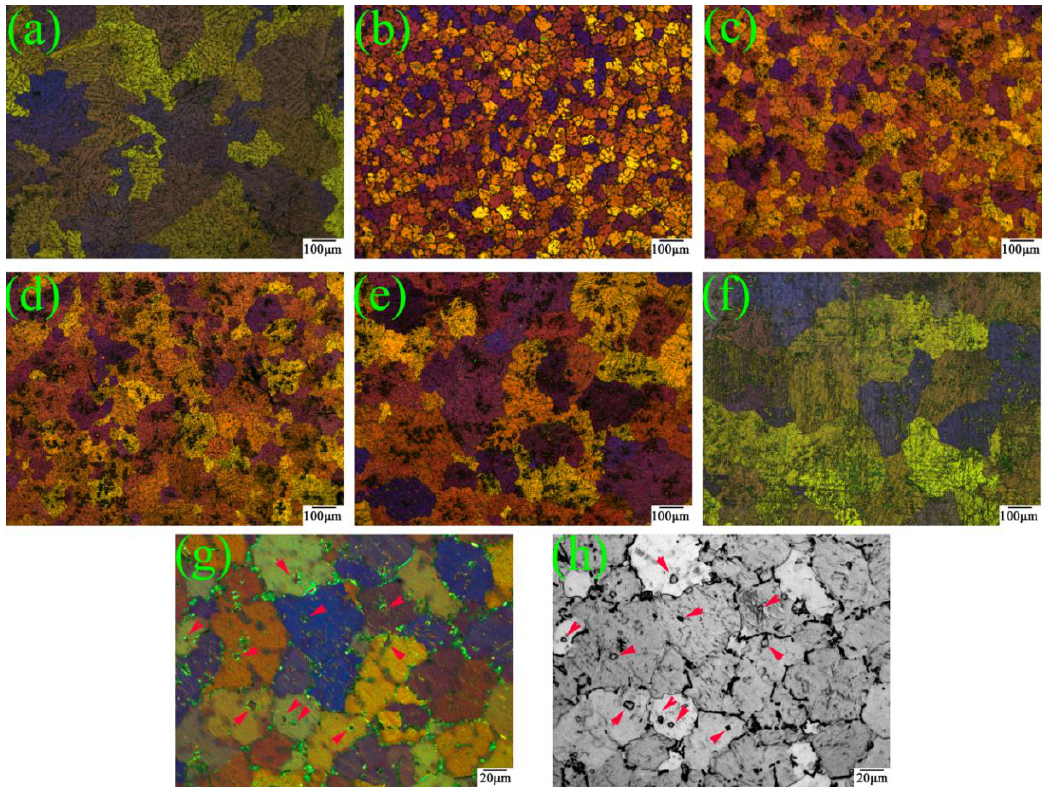
Figure 5. Optical micrographs of as-cast Mg-6Y alloys with the different addition Al contents: ( a ) 0.5%; ( b,g,h ) 1%; ( c ) 2%; ( d ) 3%; ( e ) 4%; ( f ) 5%. Materials 2018 , 11 , x FOR PEER REVIEW